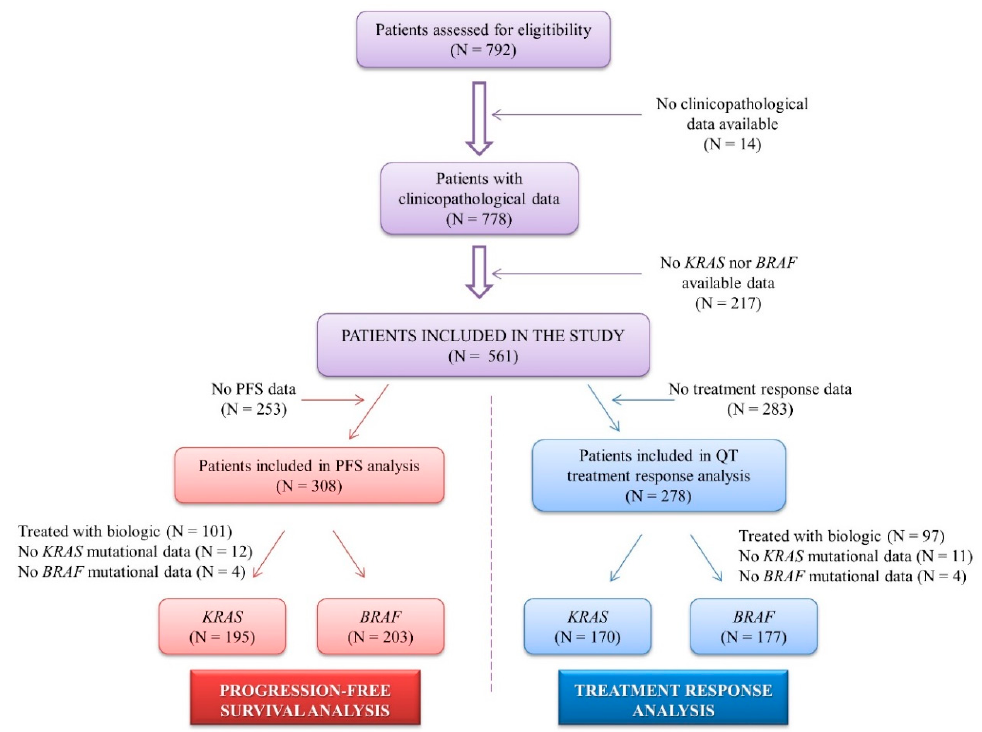
Figure 1. Flow chart presenting the number of patients in progression-free survival and chemotherapy response analyses performed in the study. N: number of patients.